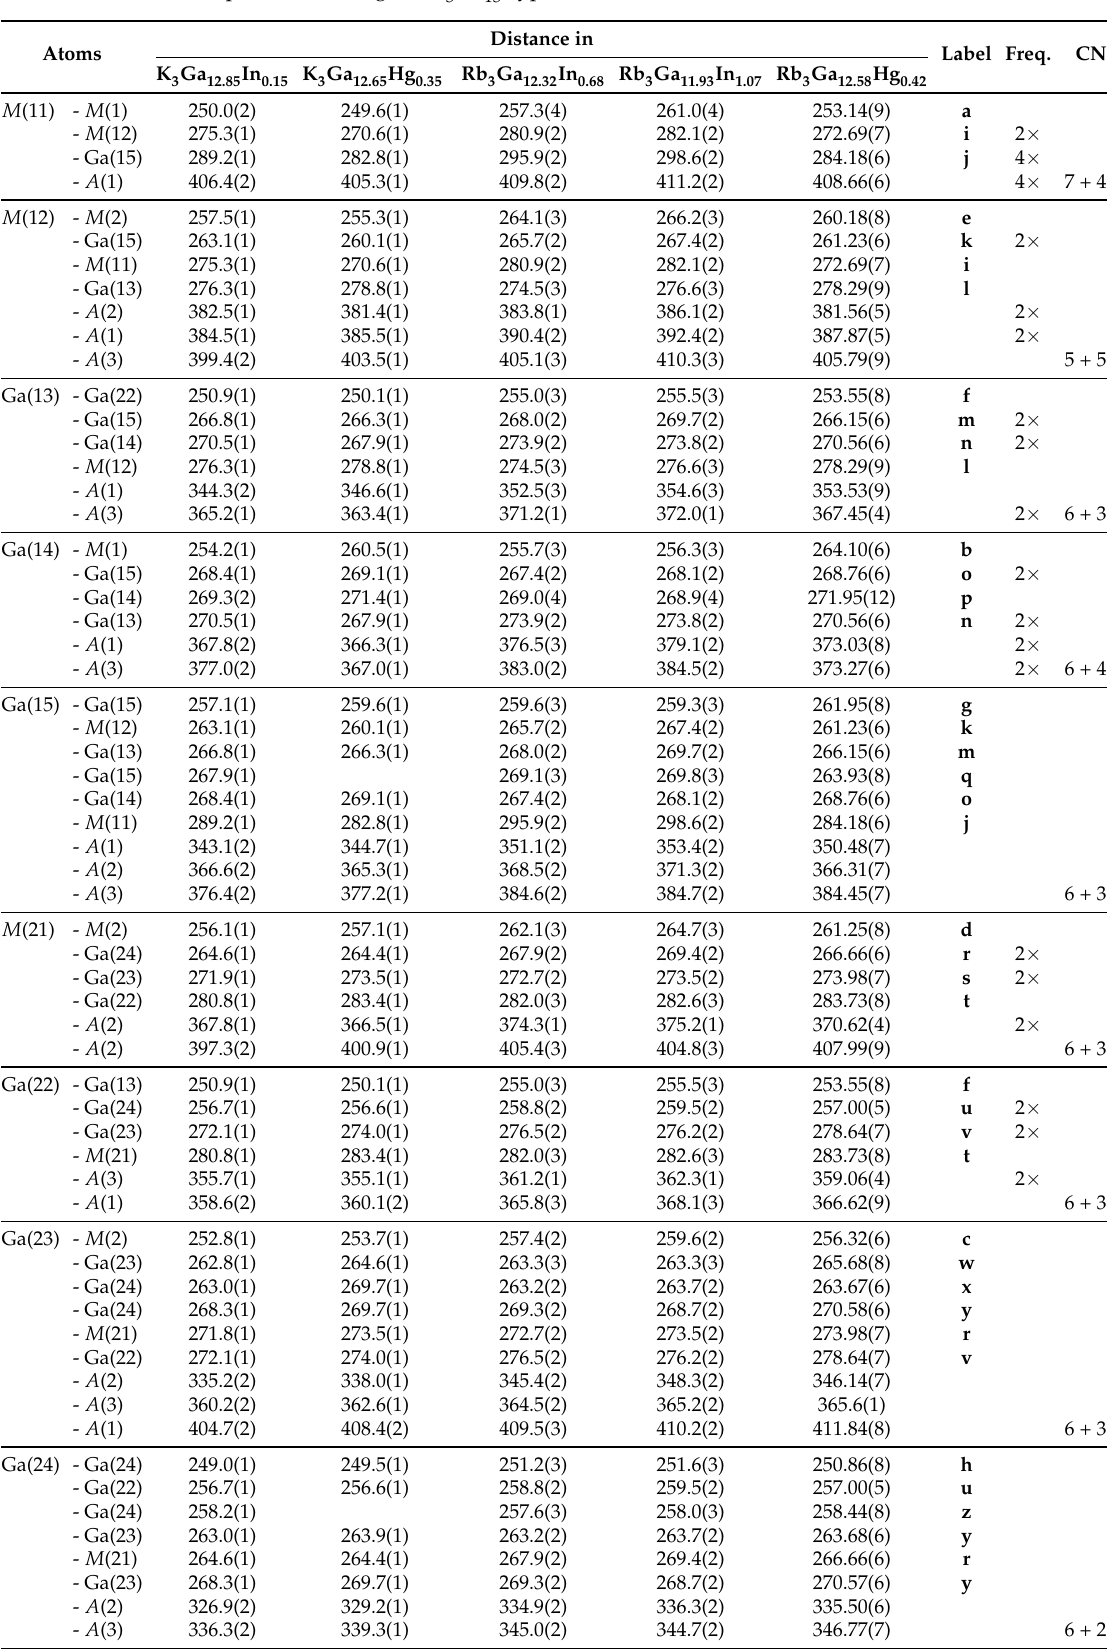
Table 7. Selected interatomic distances/pm of the cluster-forming Ga/In/Hg atoms in the crystal structures of compounds forming the K